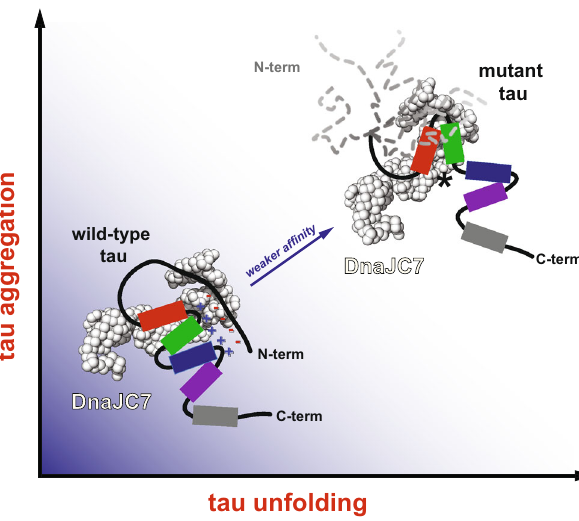
Fig. 8 Proposed model of DnaJC7 recognition of natively folded conformations of tau to ef fi ciently suppress amyloid aggregation. domain and in fl uence the conformation of the acidic N-terminal contacts with the more basic repeat domain (shown as “ minus ” and “ plus ” symbols), resulting in structural rearrangements that yield an aggregation-prone conformation. DnaJC7 binds to the folded R1R2 element in WT tau and ef fi ciently reduces aggregation. This effect is reduced in the aggregation- prone conformations, such as those found in P301L tau. Tau is colored according to the repeat domains in red, green, blue, and magenta. DnaJC7 is shown in white